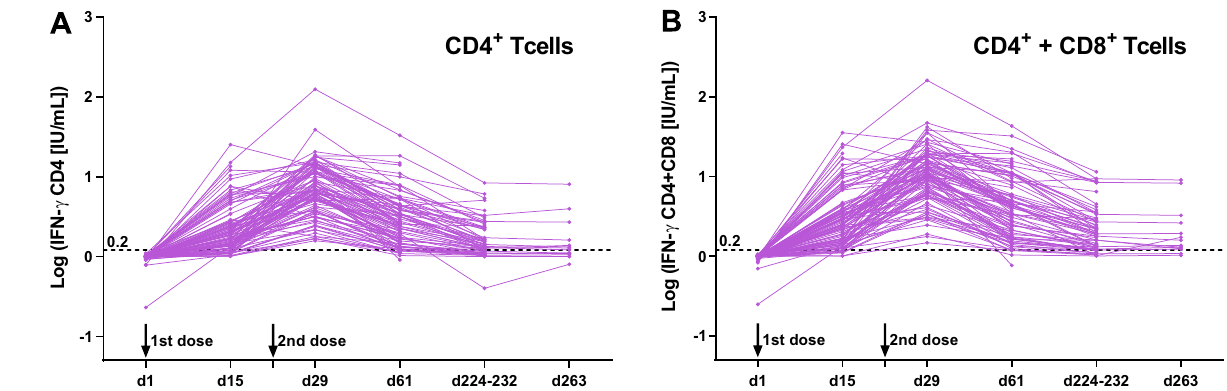
Figure 3. SARS-CoV-2 spike specific T cell response during and after BNT162b2 mRNA-based SARS-CoV-2 vaccination regimen. T cell responses on day 1 (immediately after the first dose) (n = 100), day 15 (n = 100), day 29 (7 days after the second dose) (n = 97), day 61 (n = 97), day 224–232 (n = 66), and day 263 (n = 14). The release of IFN-γ from stimulated CD4 + T cells ( A ) and both CD4 + and CD8 + T cells ( B ) with SARS-CoV-2 spike peptides using QuantiFERON SARS-CoV-2 RUO. All data were represented as line graphs using GraphPad Prism 9.3.0. Dashed lines indicate the cutoff for the